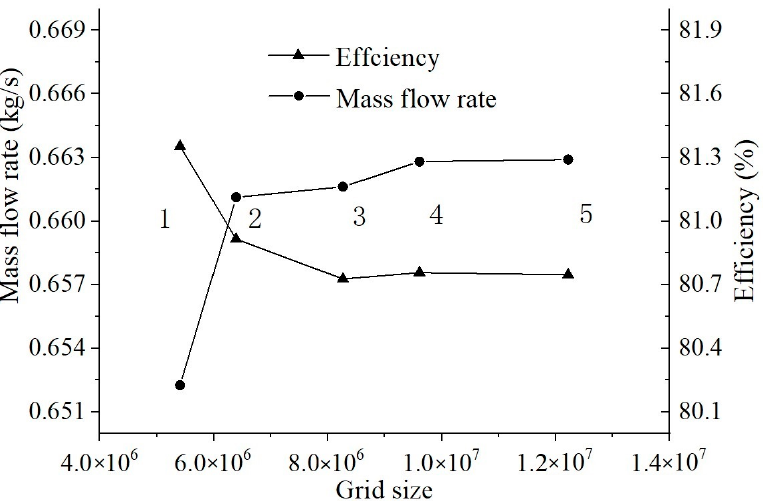
Figure 5. Predicted results with different grid sizes.